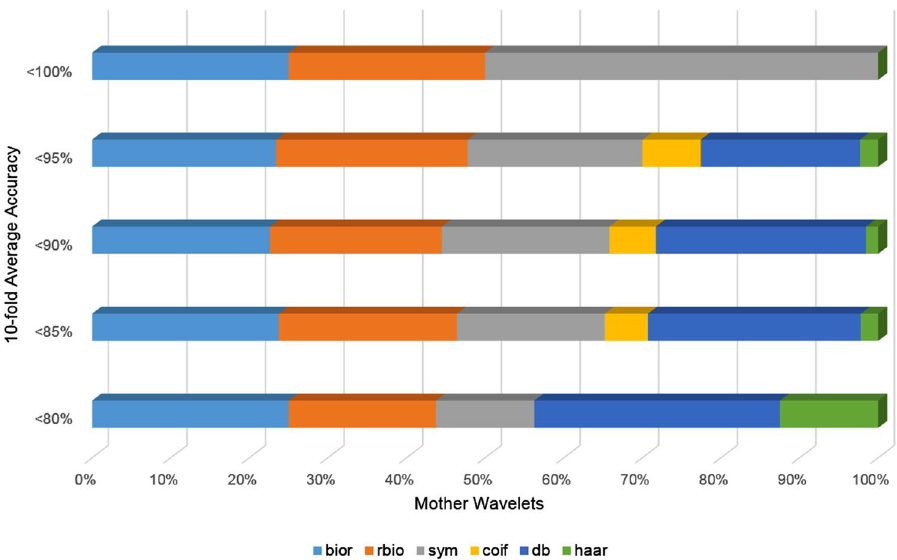
Figure 1. Performance analysis of wavelet families: Each line shows the percentage of each mother wavelet with respect to the total number of models achieving different levels of accuracy. db daubechies, sym symlets, coif coiflets, bior biorthogonal, rbio reverse biorthogonal. (Figure created in Excel 2013, https:// www. micro soft. com/ micro soft- 365/ excel).